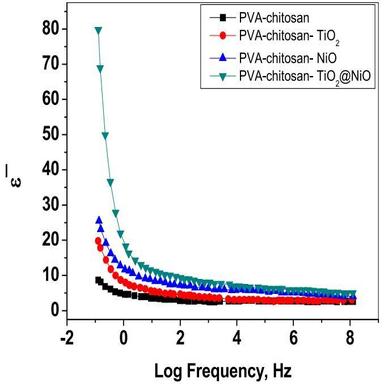
Variation in ε′ with Log f for the PVA-chitosan–TiO2, PVA-chitosan–NiO, and PVA-chitosan–TiO2@NiO films.